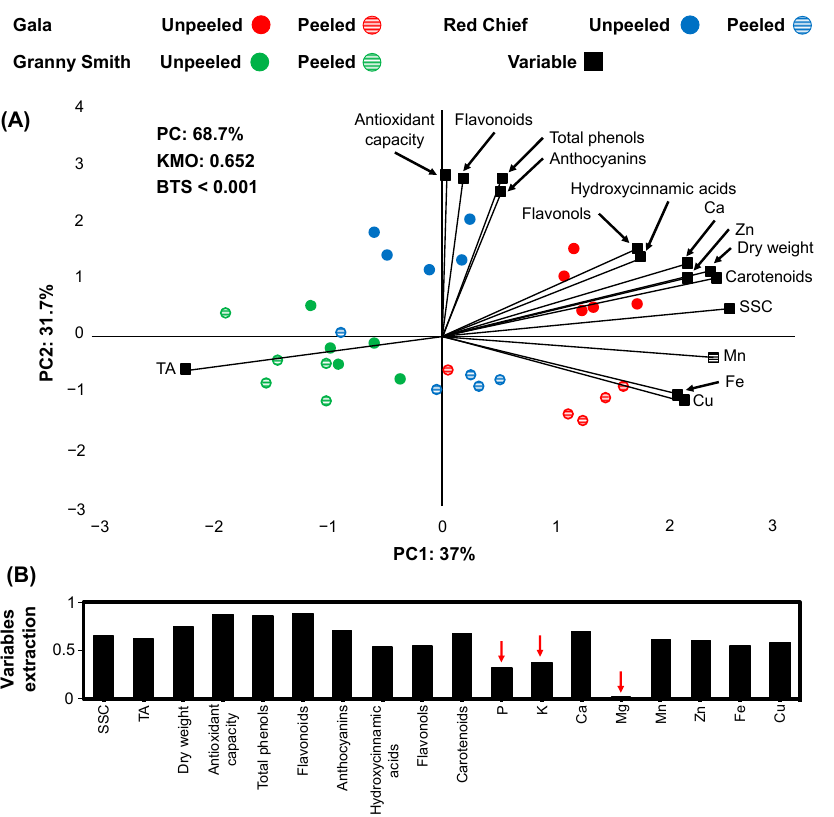
Figure 3. Principal component analysis (PCA) in a biplot ( A ) of physio-biochemical characteristics and elementary content (variables: black) of three apple cultivars (Gala: red, Granny Smith: green, Red Chief: blue) unpeeled (circle filled with color) compared to peeled (circle filled with horizontal lines) after 2 months of cold storage. Eighteen physio-biochemical and elementary variables extraction ( B ) based on the representation in the PCA model (red arrows indicate variables with low representation in the PCA model).